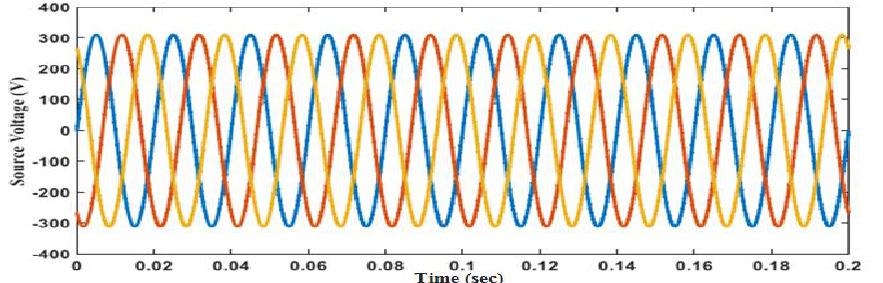
Figure 8. Source Voltage waveforms.